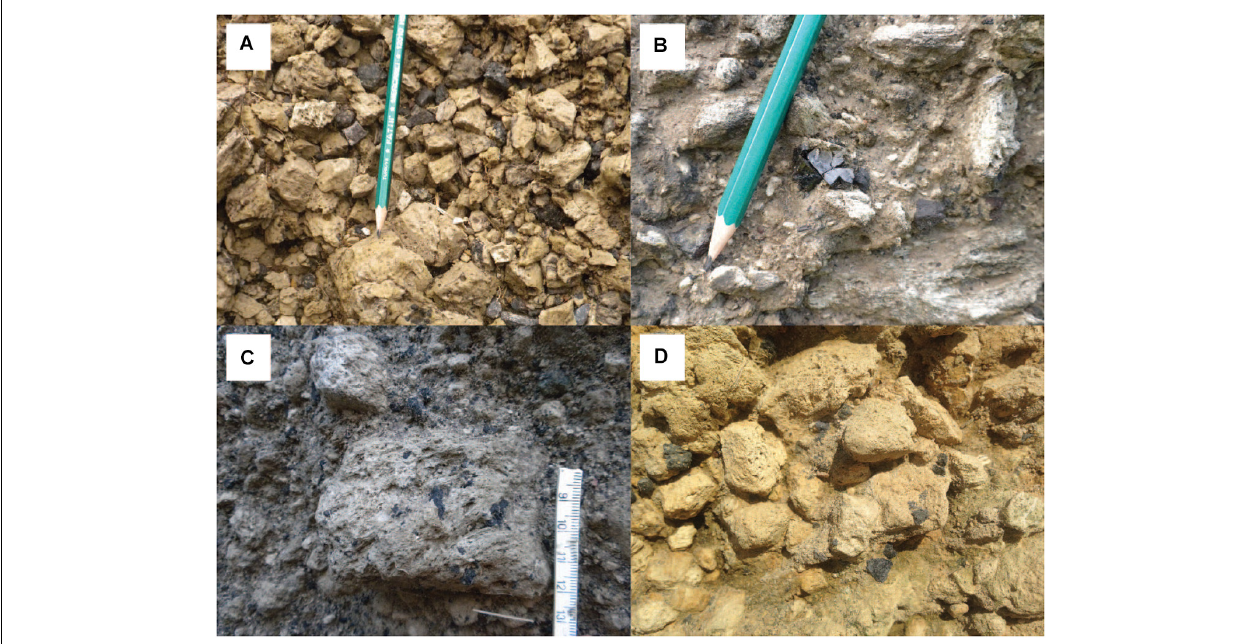
FIGURE 3 | (A) General aspect of the well-sorted fall deposit with angular pumice lapilli and subordinate lithic clasts (near Santa Bárbara village). (B) Obsidian fragments contained in the deposits of the Upper Member of the Santa Bárbara Formation (near Santa Bárbara village). (C) Large pumice lapilli with several MME (magmatic mafic enclaves) near Santa Bárbara village and (D) on the Ponta do Cintrão peninsula.